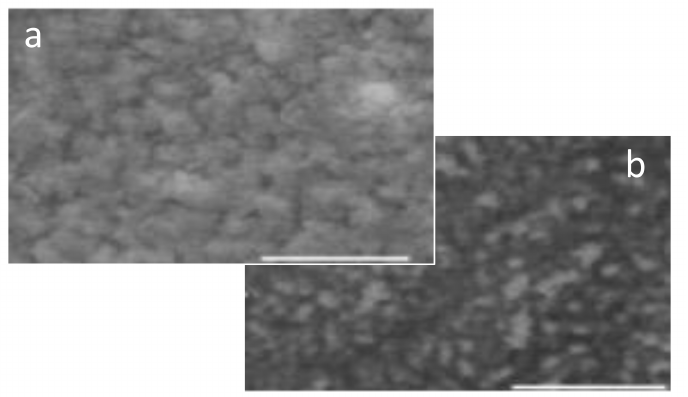
Figure 2. UV–Vis–NIR spectra of PANI-DNNSA films that were air dried (green line, a ) and thermally treated (blue line, b ), respectively.